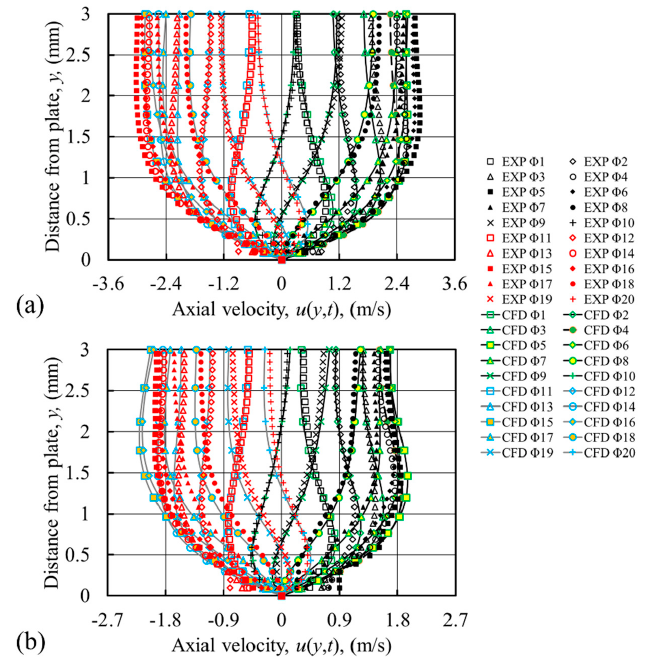
Figure 14. Comparison between velocity profiles from the experiment and the SST k- ω model; for drive ratio of ( a ) 0.65% and ( b ) 0.45%. Location 10 mm from the joint inside the cold channel.